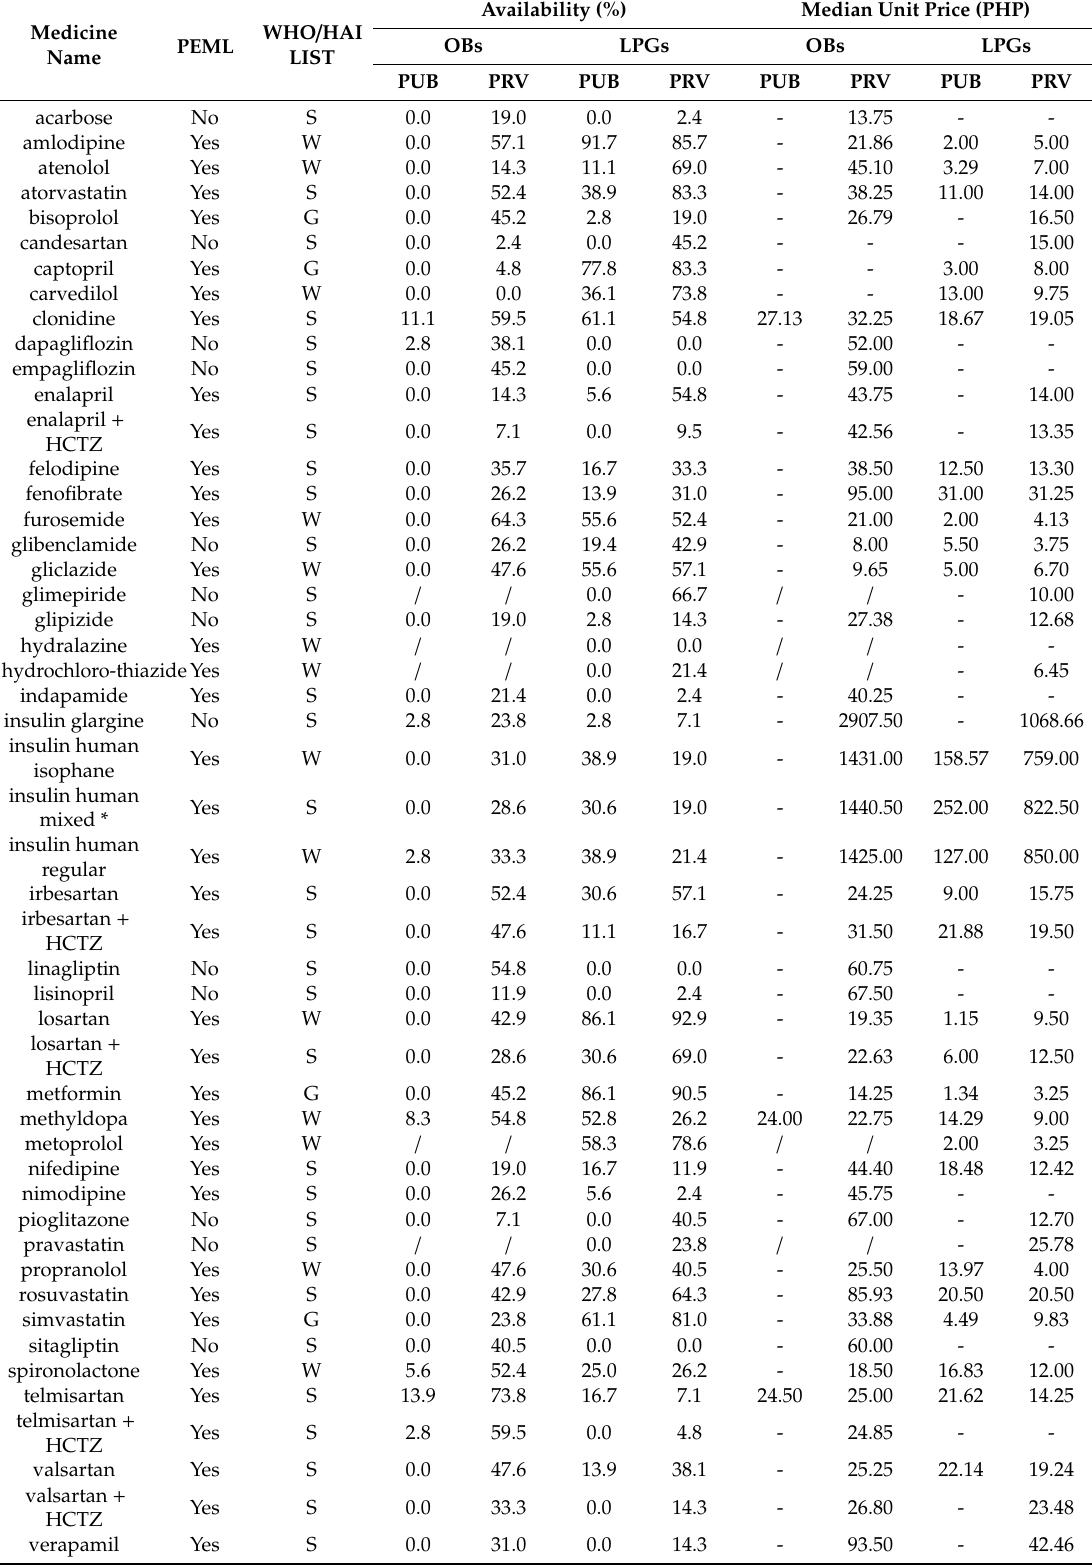
Table 1. Availability and median unit price of individual medicines in both the public and private